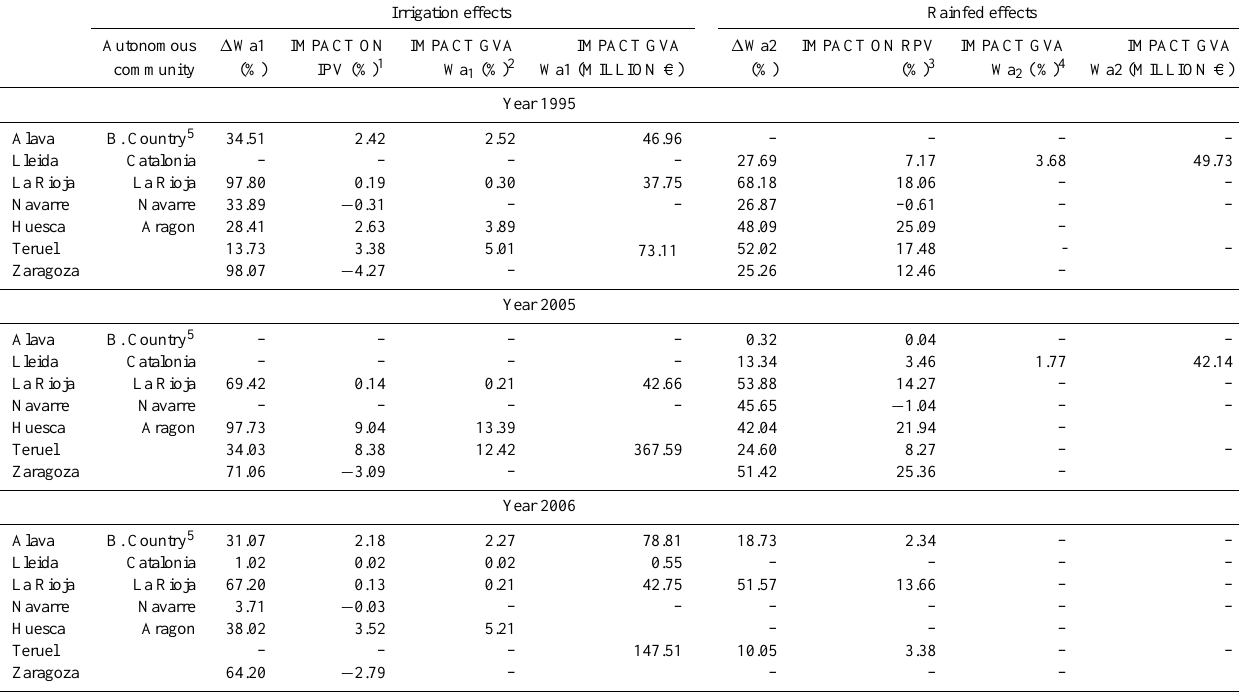
Table 6. 2005–2006 spread of impacts: percentages of reduction in water availability, impacts transmitted through elasticity on production values and on GVA (at autonomous community level only). Final indirect impacts (million C) on